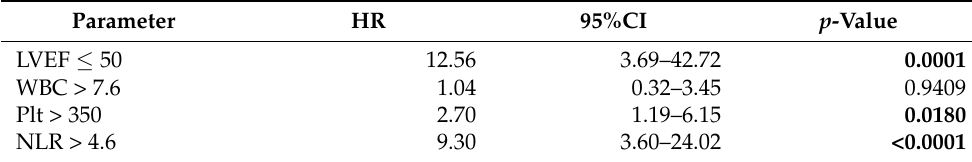
Table 4. Multivariable Cox’s proportional hazard regression analysis—binary